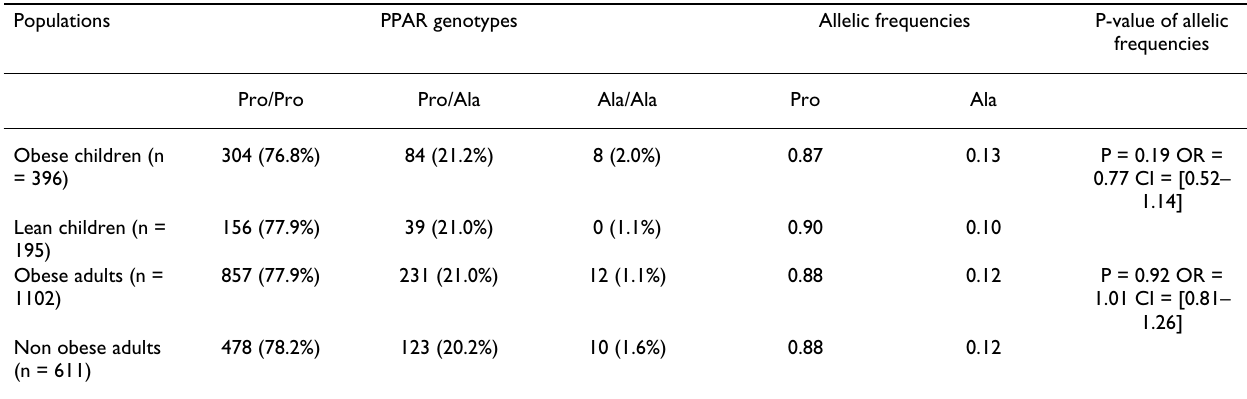
Table 2: Comparison of Genotypic and Allelic Distribution of Pro12Ala polymorphism in obese versus non obese subjects. Case/ Control studies show that the Pro12Ala polymorphism is not associated with childhood or adult obesity in the French Caucasian population (p = 0.19, p = 0.92